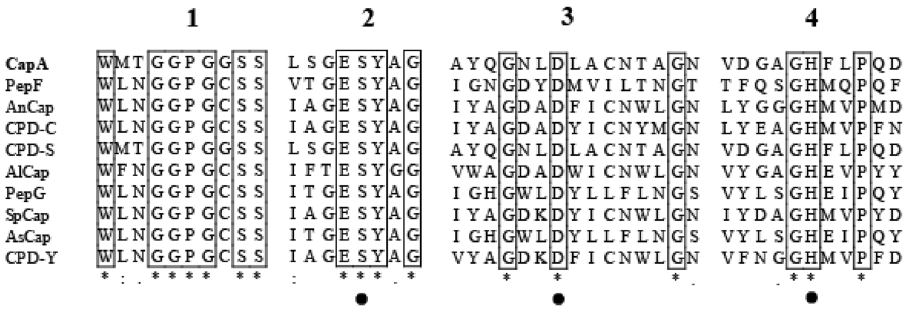
Figure 1. Multiple sequence alignment of serine carboxypeptidases from different microorganisms. (*): conserved amino acid; (:): conservative replacement; (.): semi-conservative substitution; and the amino acid residues of the active sites are marked with black dots. The four conservative domains (1, 2, 3, and 4) are indicated